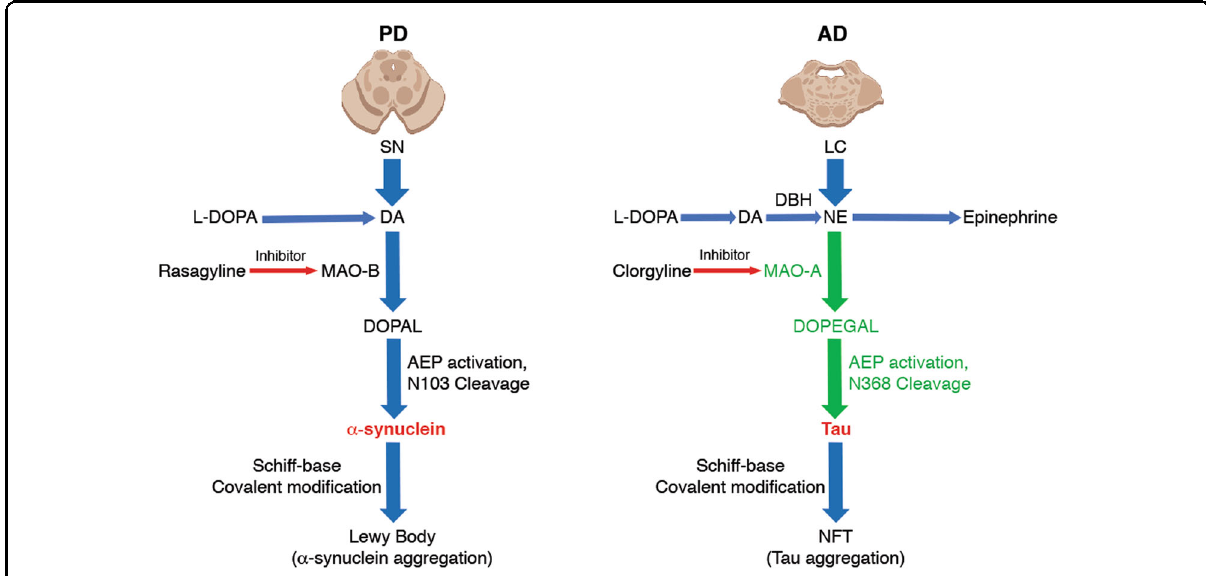
Fig. 4 Schematic models for the selective vulnerability of dopaminergic and noradrenergic neurons in Parkinson ’ s disease and Alzheimer ’ s disease. DA metabolites by MAO-B and DOPAL display toxic effects in PD pathology speci fi cally in the substantia nigra, leading to δ -secretase activation and alpha-synuclein cleavage and toxicity (left). Similarly, MAO-A and its toxic NE metabolite, DOPEGAL, induce tau truncation and toxicity by activating δ -secretase in noradrenergic cells of the locus coeruleus in the early stage of AD progression